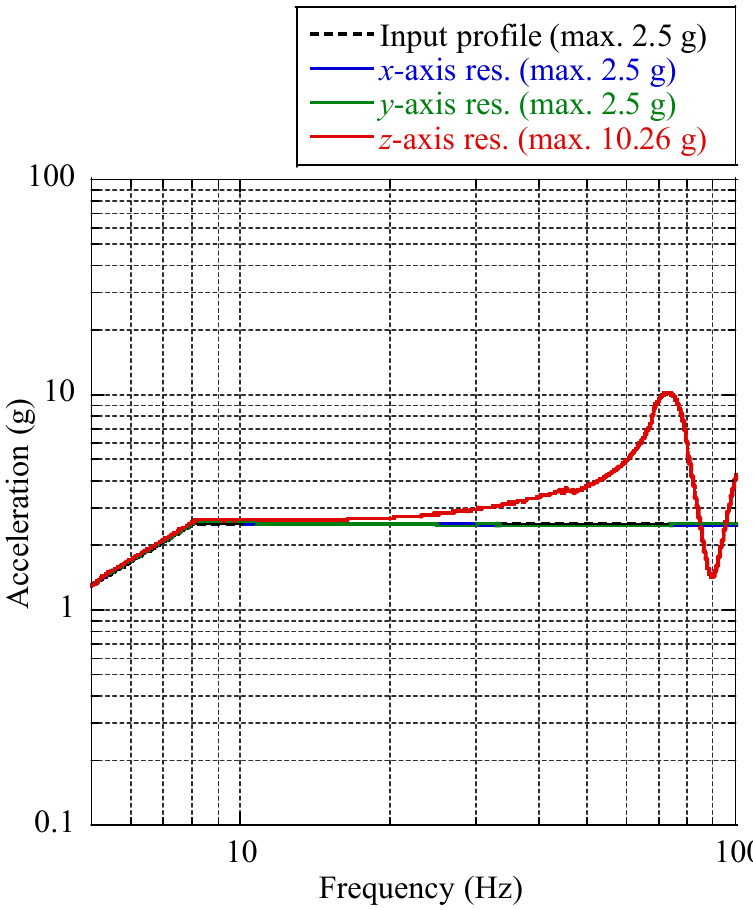
Figure 15. The results of VMLSA’s corresponding axis sine vibration tests in the x -, y -, and z -axis excitations.